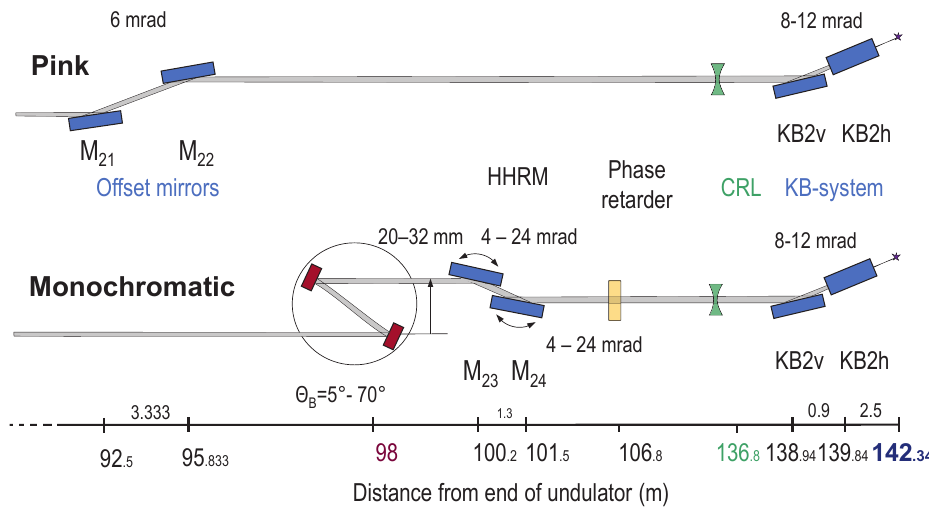
Figure 17. Schematic layout of the Aramis-2 X-ray optics for pink beam ( top ) and monochromatic beam ( bottom ).